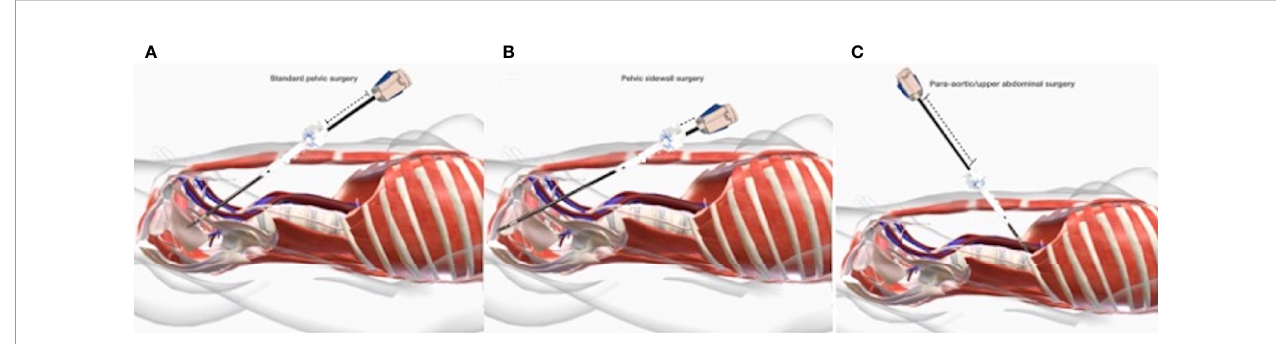
FIGURE 4 | (A) Standard pelvic surgery; (B) Pelvic sidewall surgery; (C) Para aortic/upper abdominal